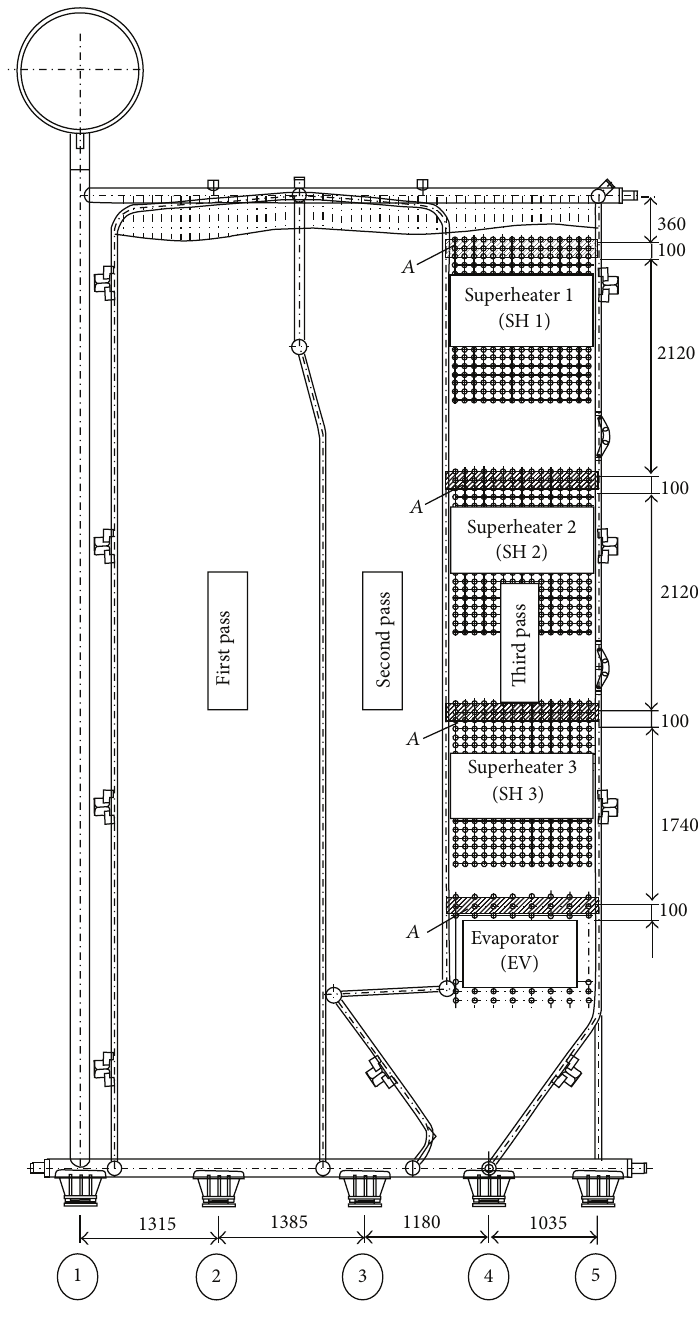
Figure 7: Position of boiler supports and heat exchangers (dimensions are in